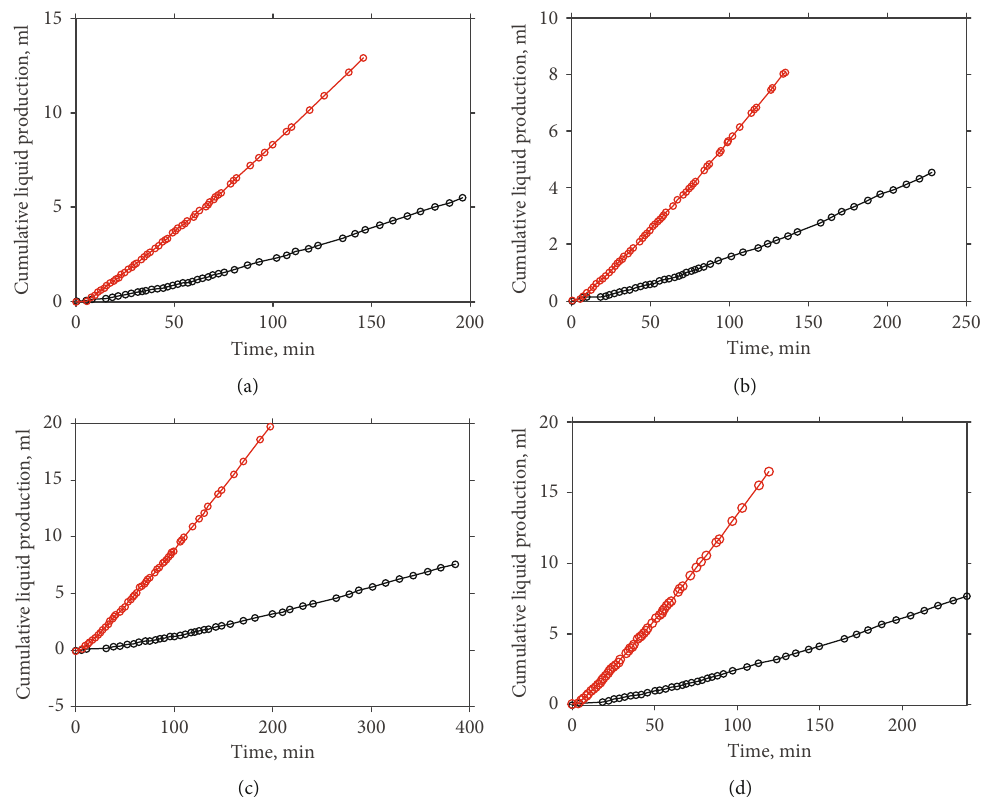
Figure 5: Cumulative liquid production with respect to the water fl ooding tome before and after the construction of fracture in the experimental core. The red and black points represent the results before and after the construction of fracture. (a) Cores H1-5. (b) Cores H11. (c) Cores H13. (d) Cores